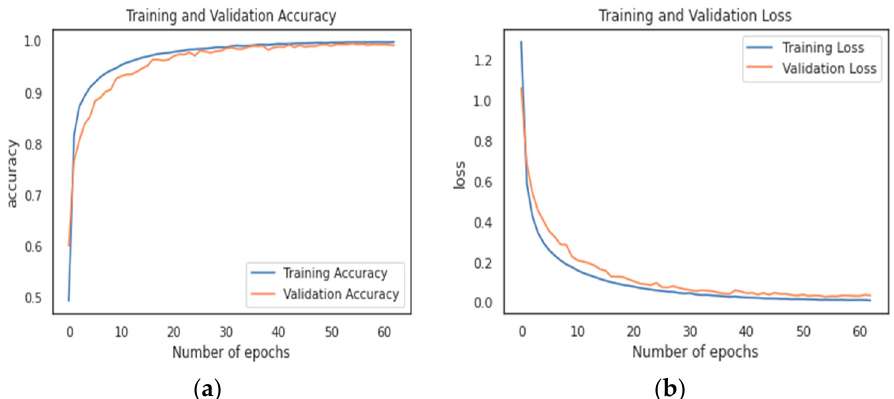
Figure 8. Line graph showing ( a ) accuracy plot and ( b ) loss plot as a function of number of epochs for the contextual model.